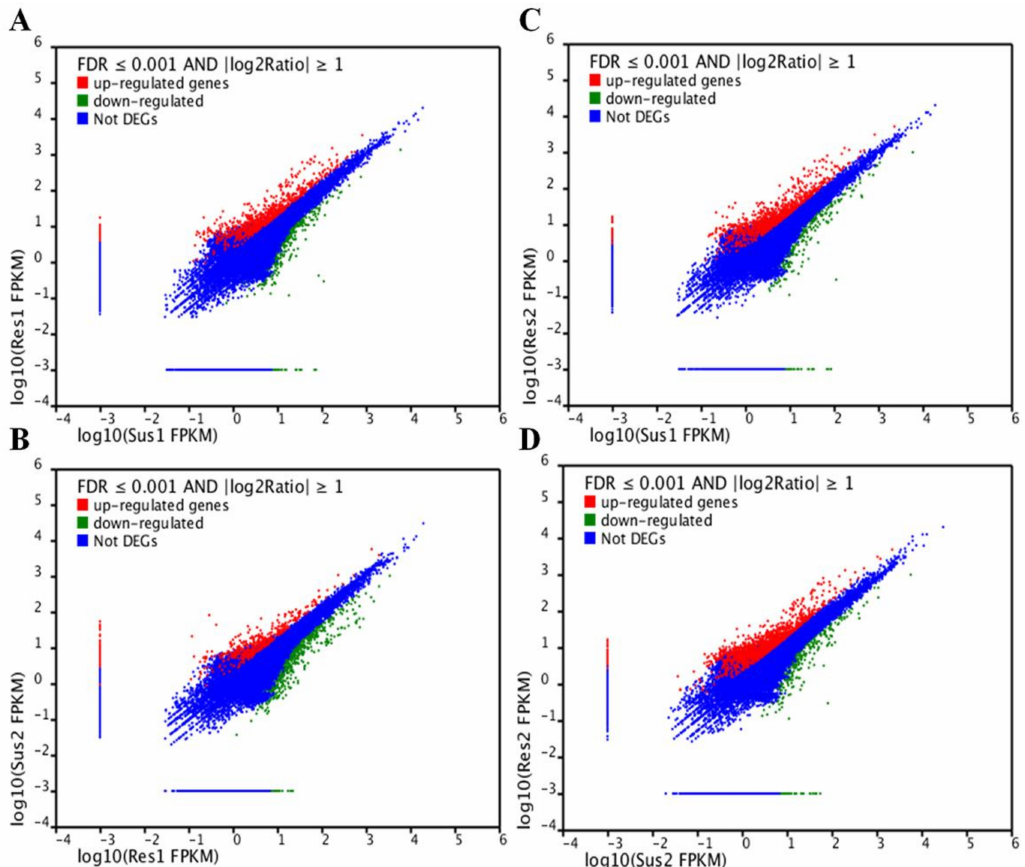
Figure 4. Differently Expressed Genes (DEGs) in resistance compared to susceptible strains shown in a graphic rep- resentation for each comparison: Sus1 vs. Res1 ( A ), Sus1 vs. Res2 ( B ), Res1 vs. Sus2 ( C ), Sus2 vs. Res2 ( D ). In the tested onion thrip populations, genes were considered DEG if False Discovery Rate (FDR) ≤ 0.001 and log2 (sample1 expression/sample2 expression) ≥ 1. Unigenes shown in red are significantly up regulated and those shown in green are significantly down